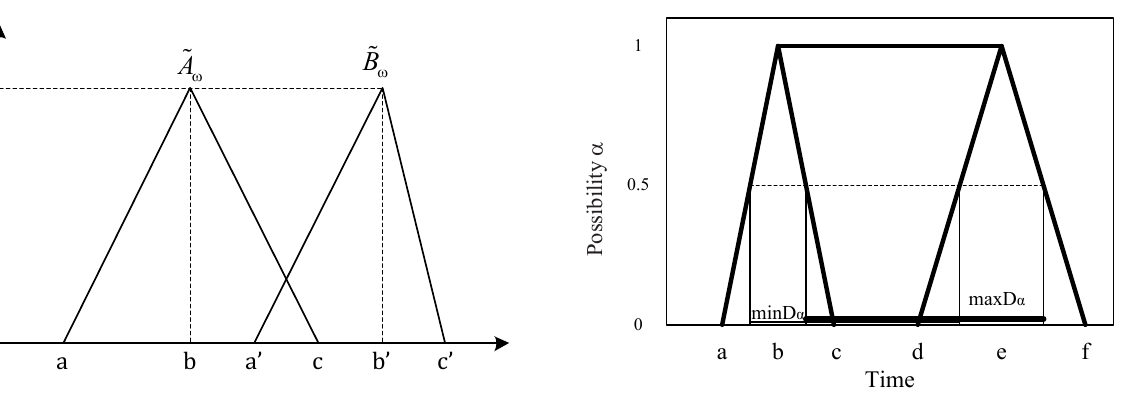
Fig. 4. Fuzzy activity start and completion date (Maravas, Pantouvakis